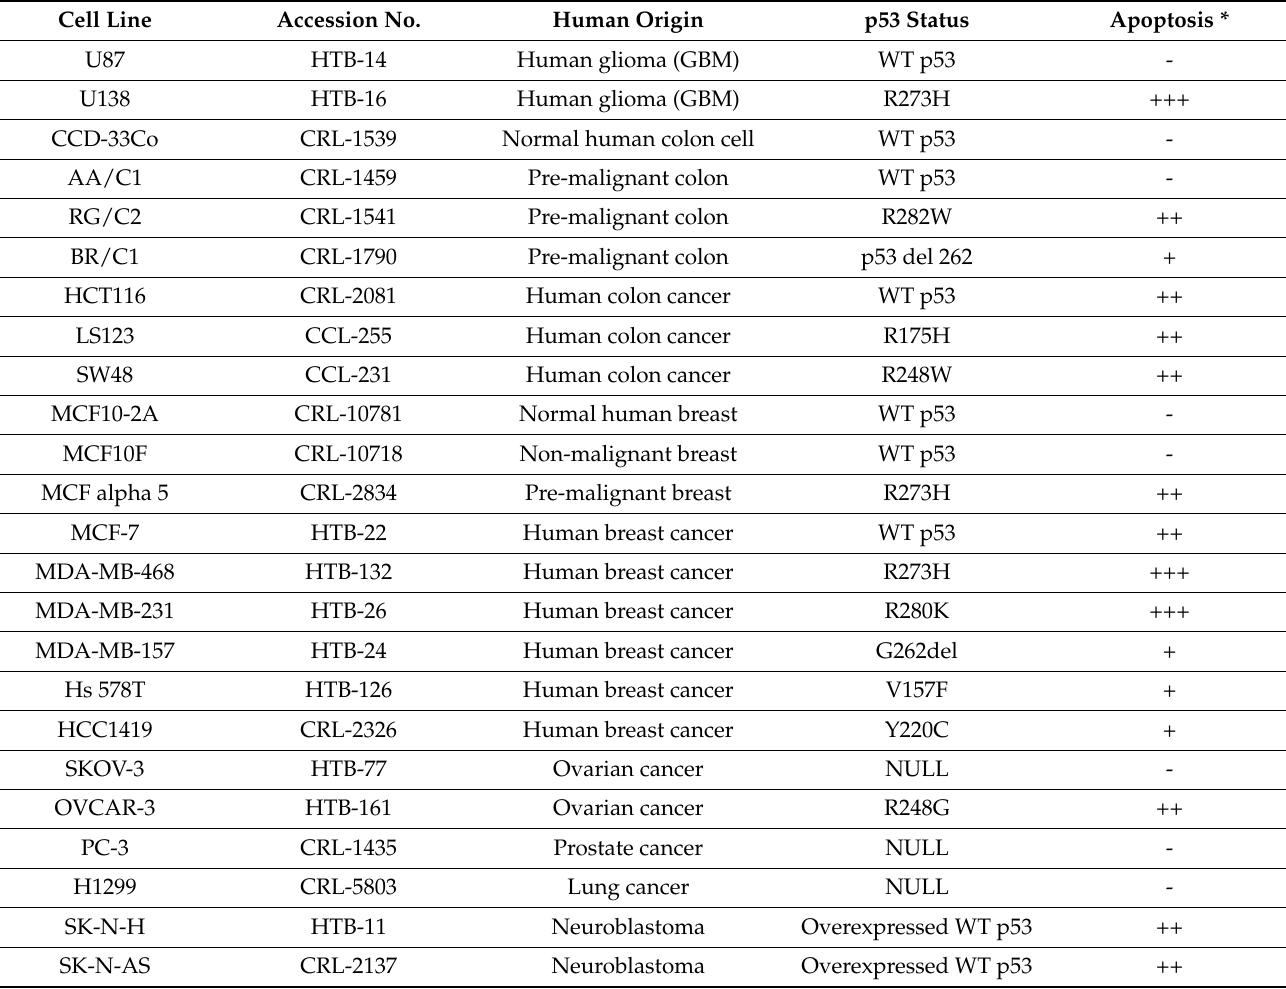
Table 1. Effect of Peptide on Cell